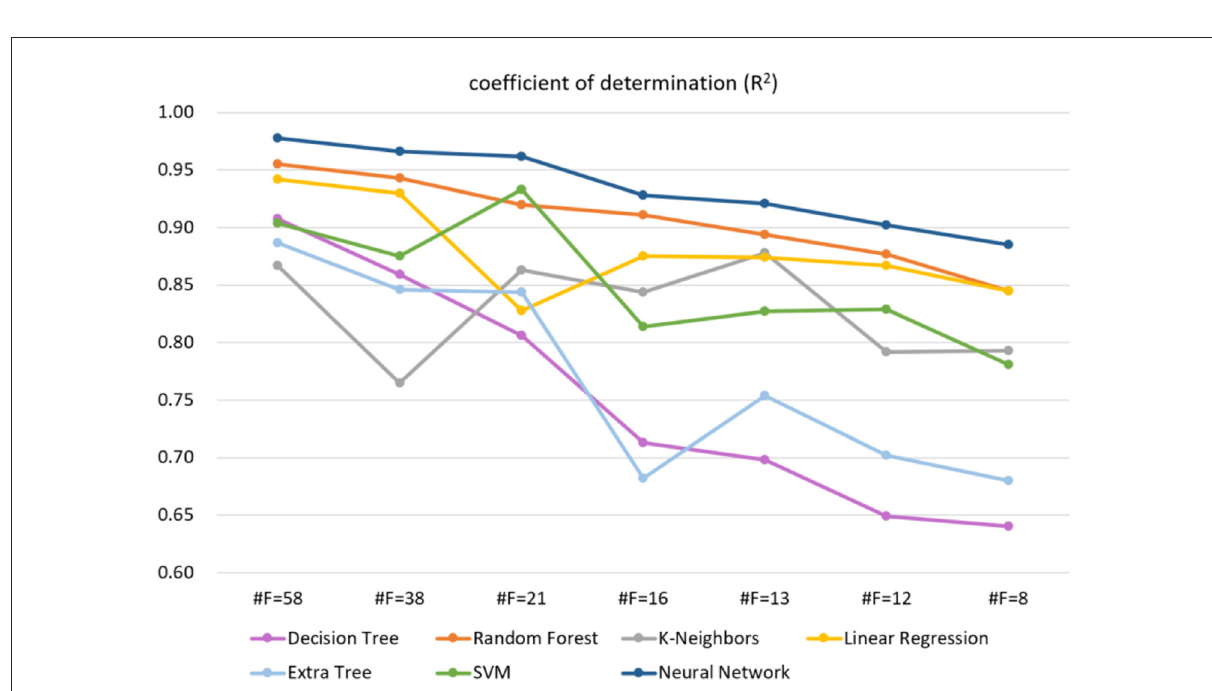
(1) fewer measurement metrics, (2) less measurement